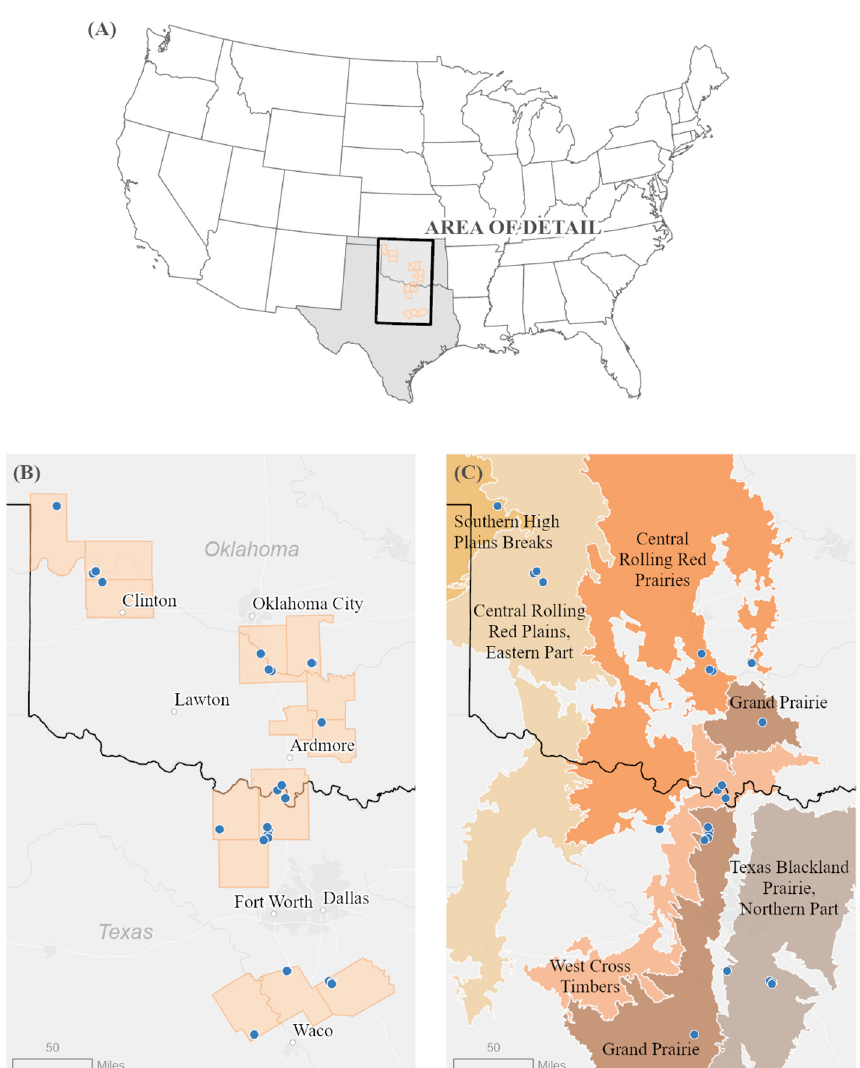
Figure 1. Location of the study sites in ( a ) United States area of detail, ( b ) Oklahoma and Texas counties and sampling locations (blue dots), ( c ) the USDA-NRCS Major Land Resource Areas and sampling locations (blue dots).